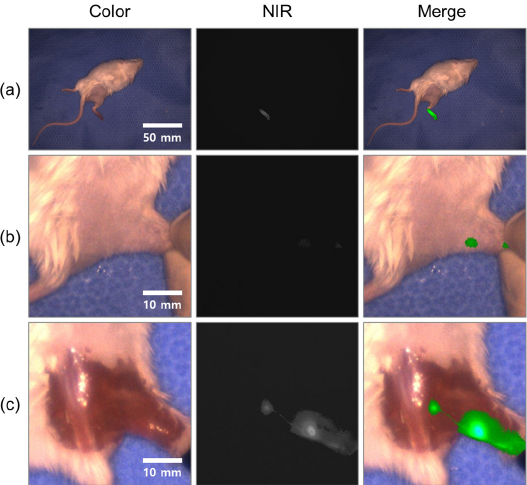
Figure 9. In vivo evaluation of the system. ( a ) ICR mouse 5 min after injection of ICG ( b ) right groin of the mouse ( c ) iliac lymph node and popliteal lymph node of the mouse after skin incision.